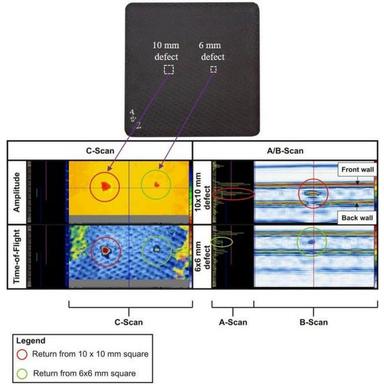
Ultrasonic investigation of panel 1.